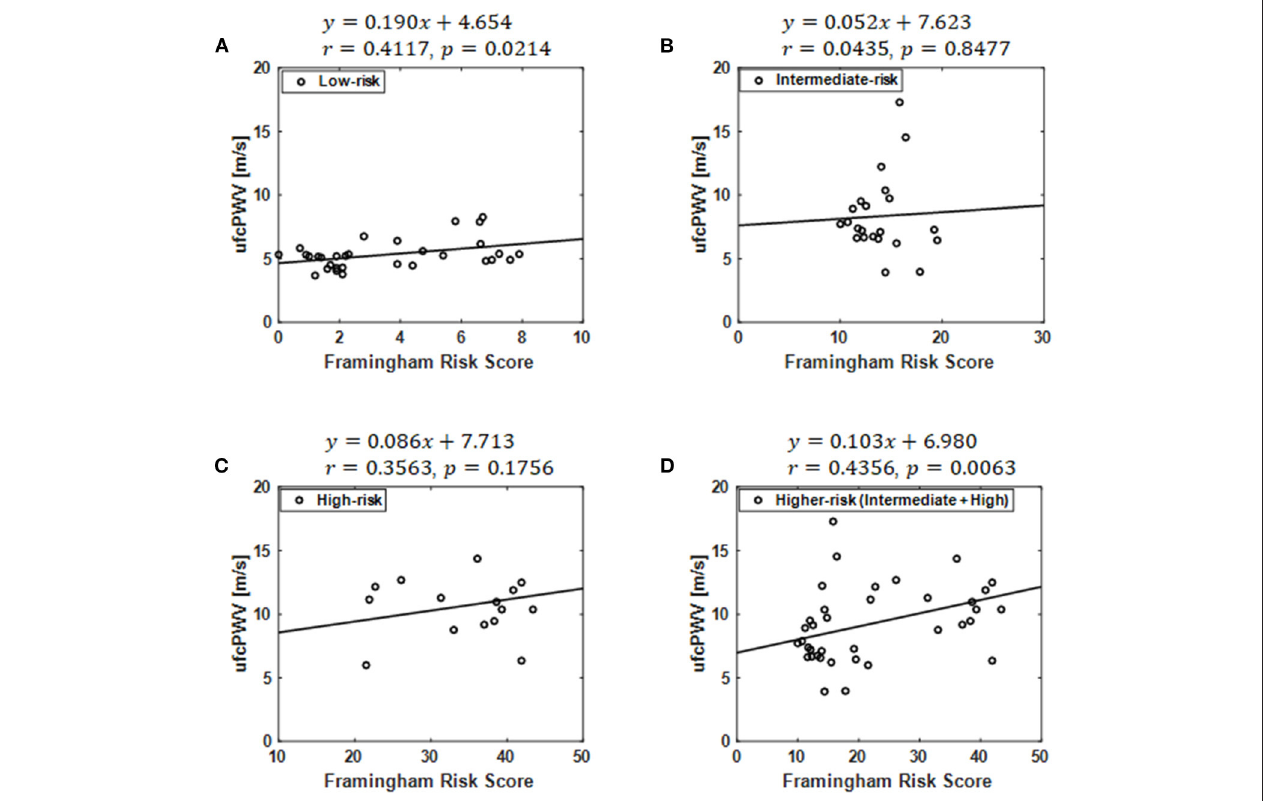
FIGURE 3 | Correlation between the ufcPWV based on ultrafast curved array imaging and Framingham risk score in the case of (A) the low-risk model, (B) the intermediate-risk model, (C) the high-risk model and (D) the higher-risk model combined with the intermediate and the high-risk